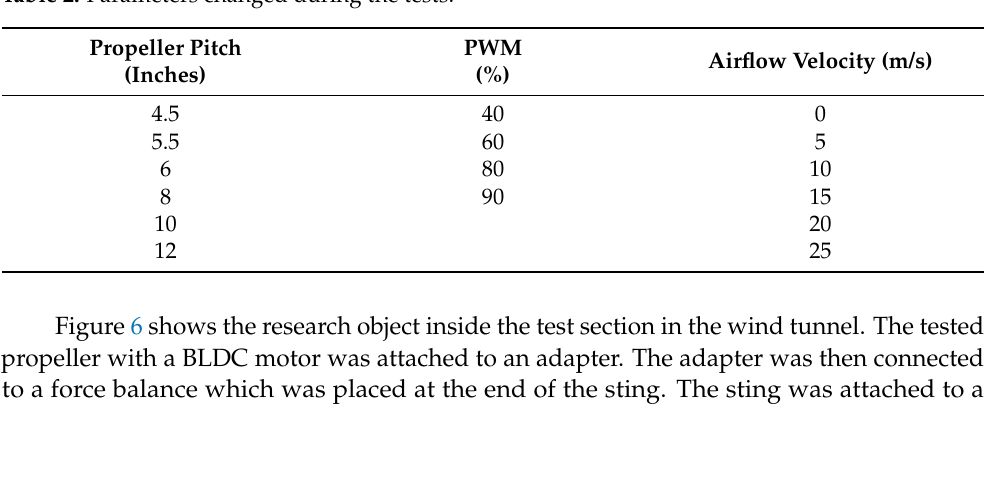
Table 2. Parameters changed during the